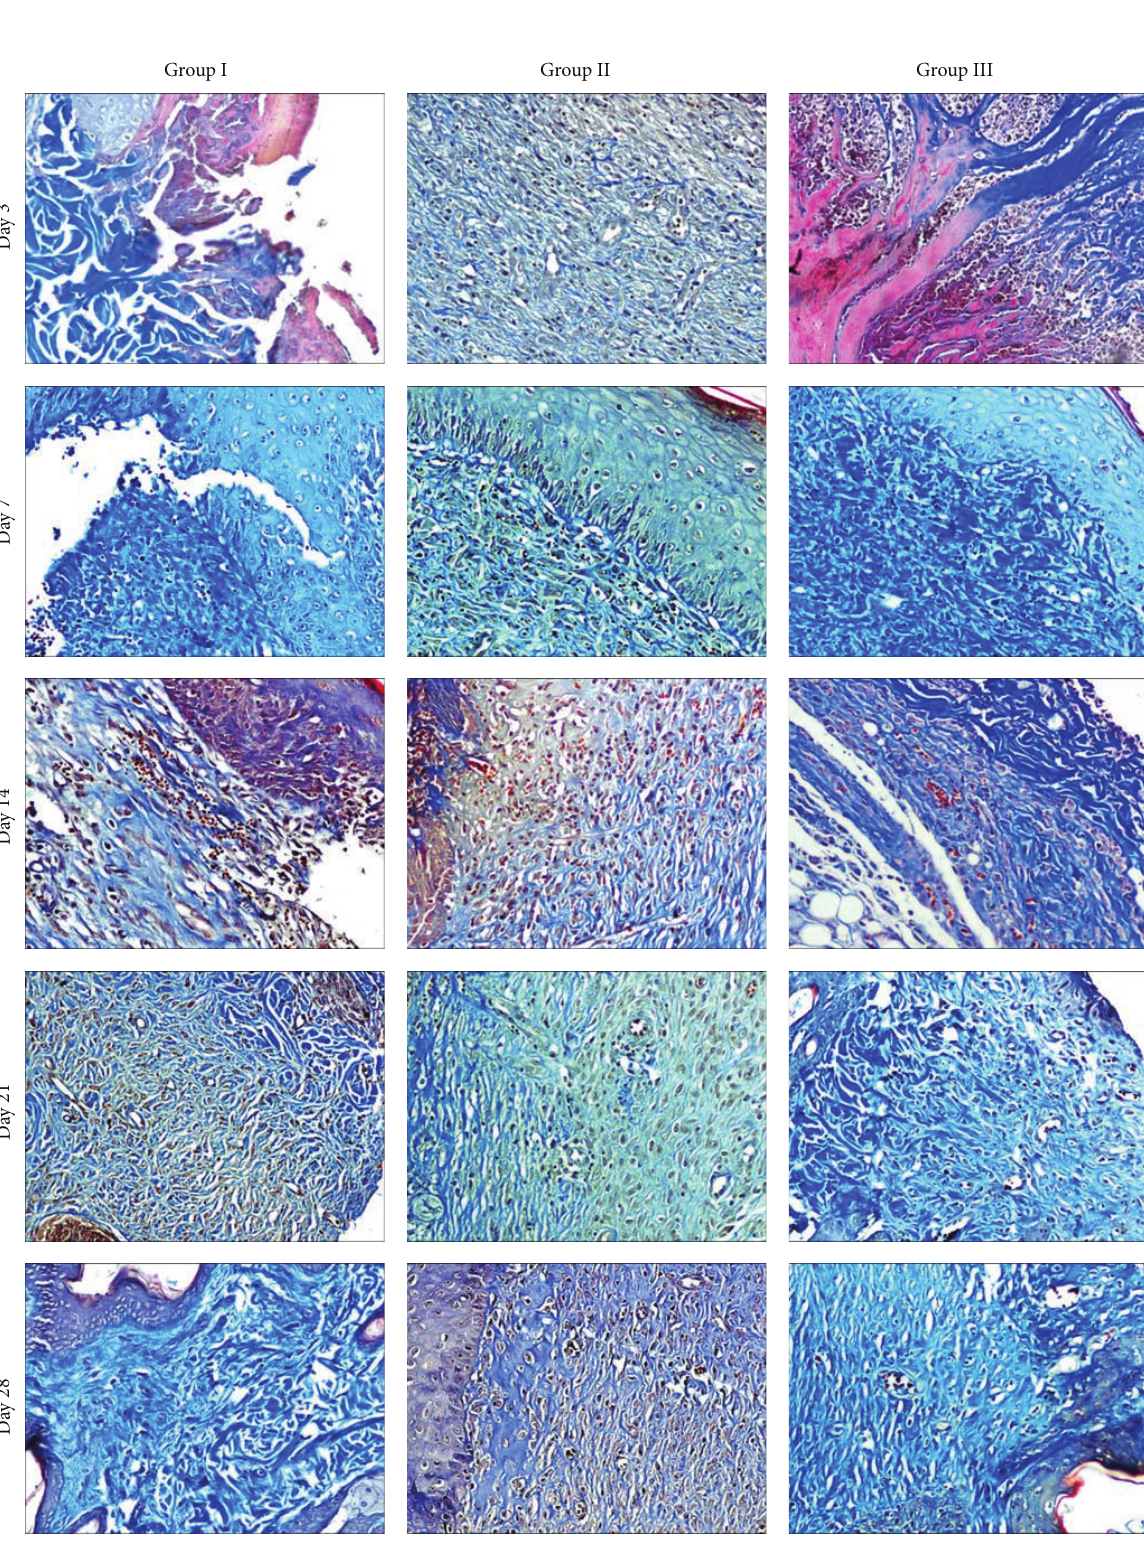
Figure 7: Microphotograph of different groups at different time intervals (Masson’s trichrome stain,